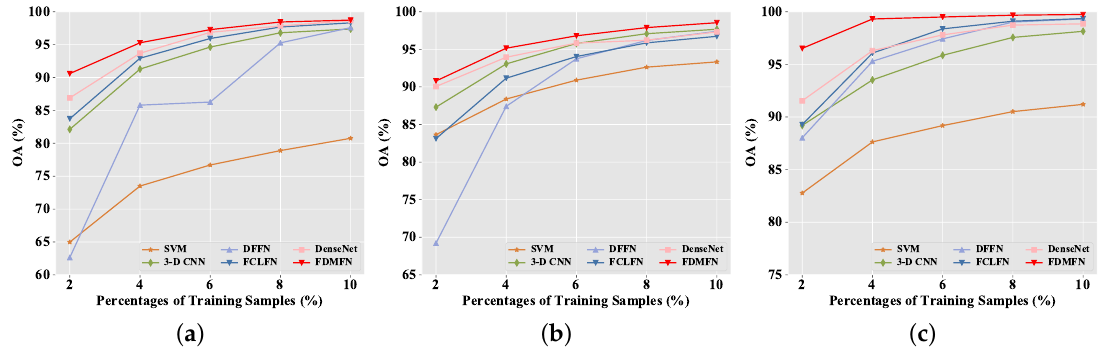
Figure 10. Overall accuracy (OA) of different methods when using different ratios of labeled data for training on the ( a ) IP, ( b ) UH, and ( c ) KSC datasets.